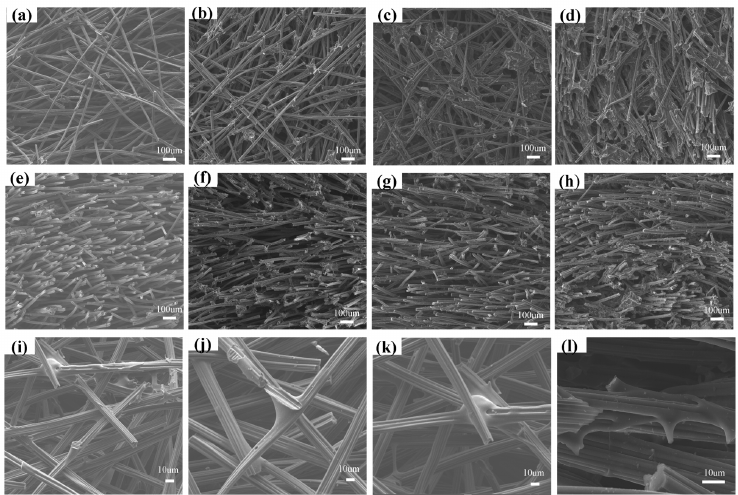
Figure 5. SEM images in XY direction and Z direction of ( a , e ) CBCF ‐ 1, ( b , f ) CBCF ‐ 2, ( c , g ) CBCF ‐ 3, and ( d , h ) CBCF ‐ 4. ( i – l ) High magnification SEM images of CBCF ‐